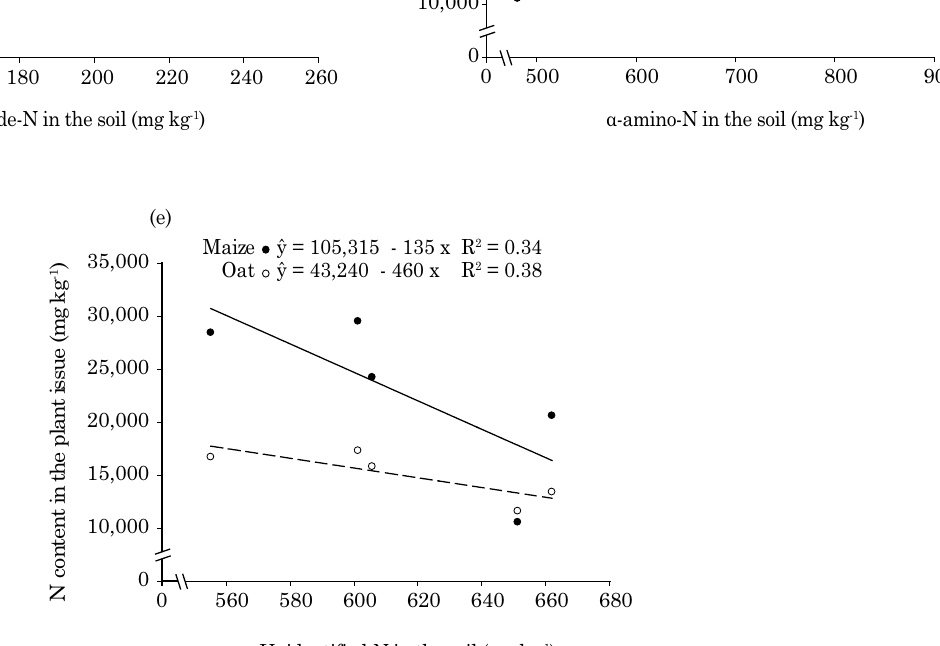
Figure 4. Relation between the n contents in the form of (a) nH + 4 -n, (b) hexosamine-n, (c) amide-n, (d) α-amino-N, and (e) unidentified-N in the soil in the 0-10 cm layer, and N content in the leaves of maize and oat subjected to 10 years of annual fertilization with pig slurry at the application rates of 0, 25, 50, 100, and 200 m -3 ha -1 in a no-till